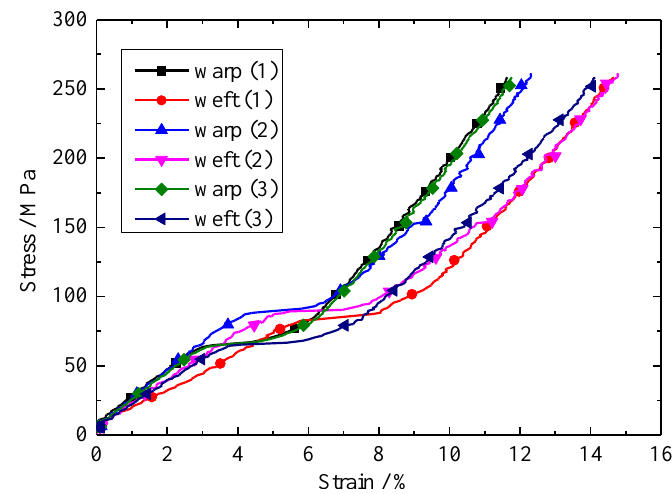
Figure 5. Stress–strain curves of the biaxial tensile tests under equal loading ratio in warp and weft directions.